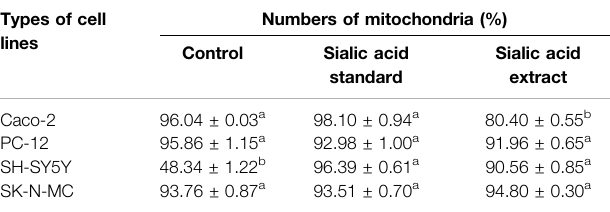
TABLE 3 | The numbers of mitochondria in fl ow cytometer analysis for Caco-2, PC-12, SH-SY5Y, and SK-N-MC cell